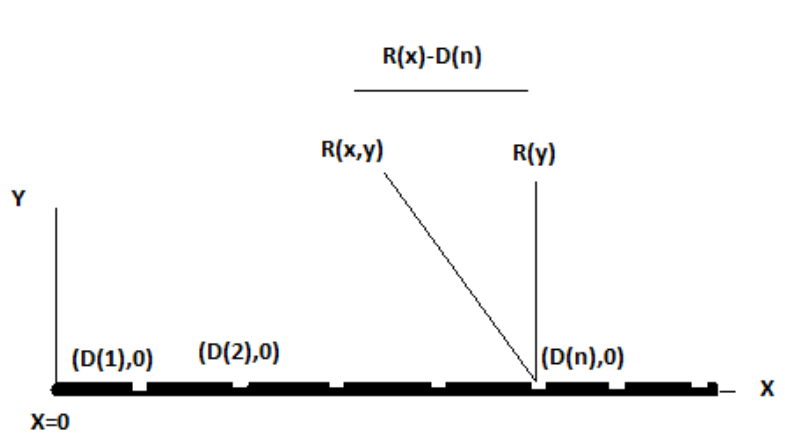
Figure 1. Basic configuration of the leaky coaxial cable.